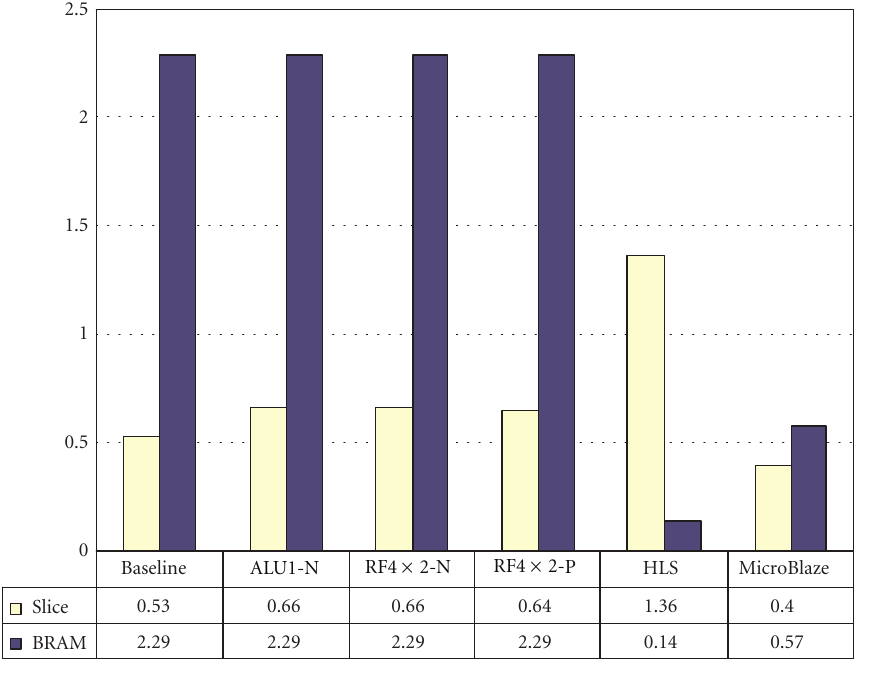
Figure 21: Area comparison for dct32 relative to manual